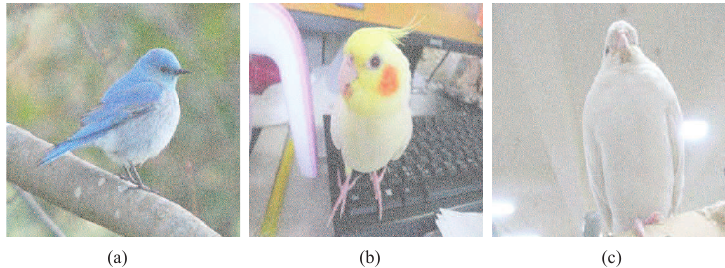
Figure 13. Color meaningful shadows of the proposed ( 3,3 ) -SDIS sharing a true color secret image: